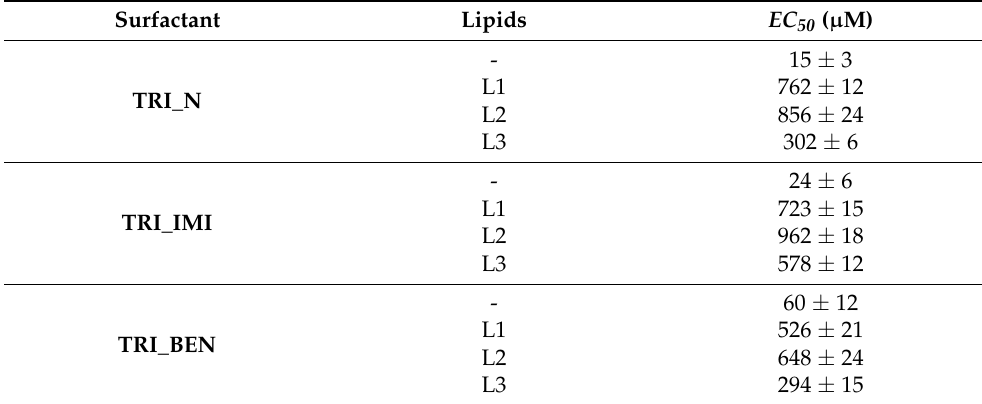
Table 3. Results of half maximal effective concentration— EC 50 —for studied lipoplexes.